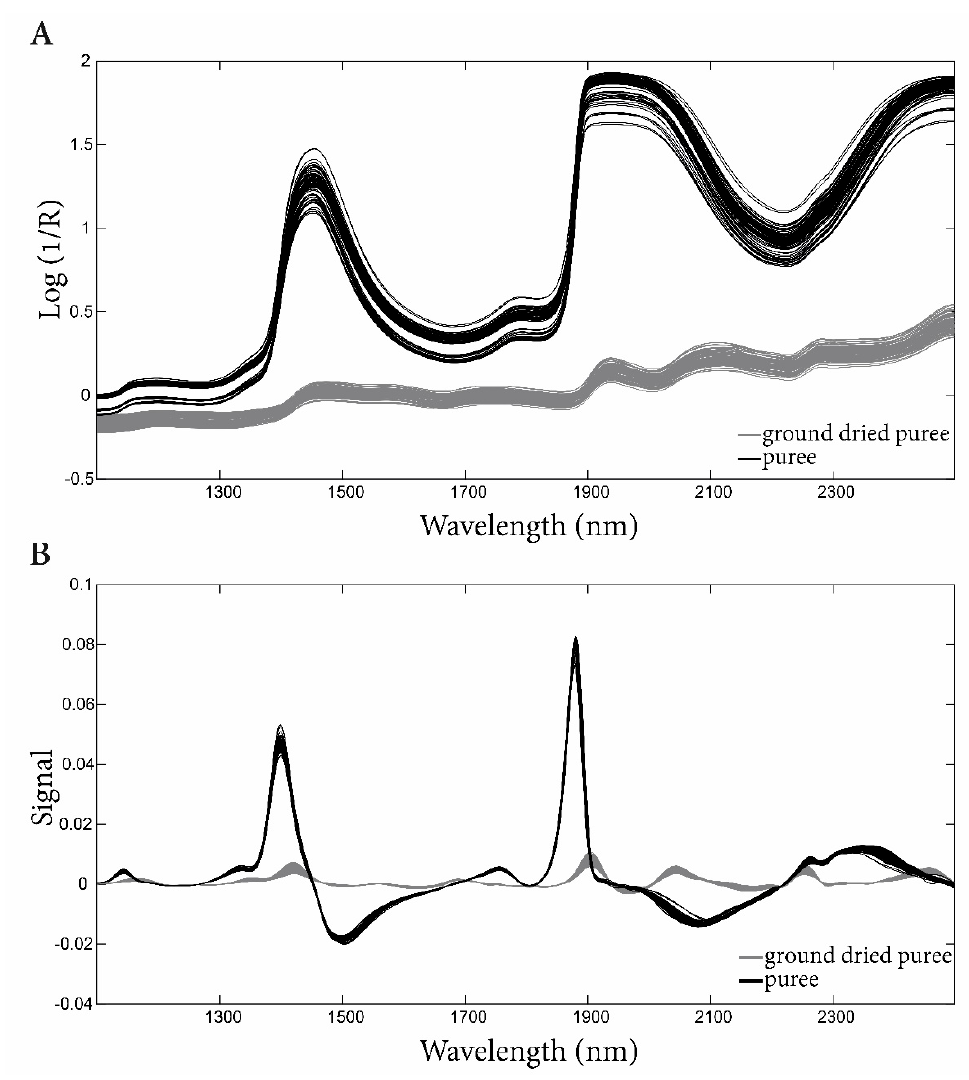
Figure 1. ( A ) Raw spectra from puree and ground dried puree; ( B ) pretreated spectra (SNV) from puree and ground dried puree.